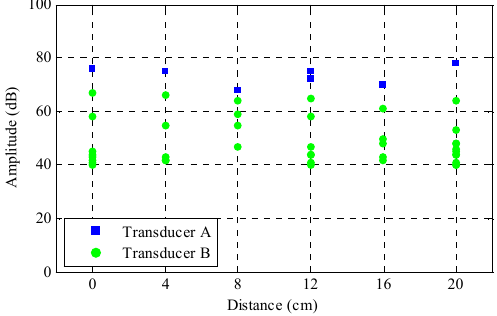
Figure 4. Amplitude from both transducers at different locations.